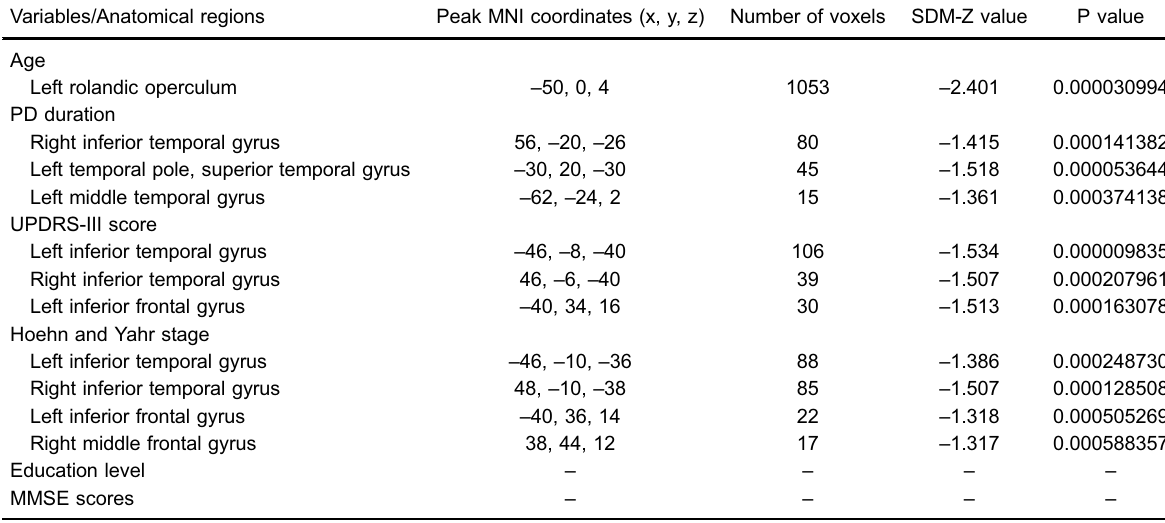
Table 2. Meta-regression analyses of demographic and clinical variables in Parkinson ’ s disease with mild cognitive impairment patients. Variables/Anatomical